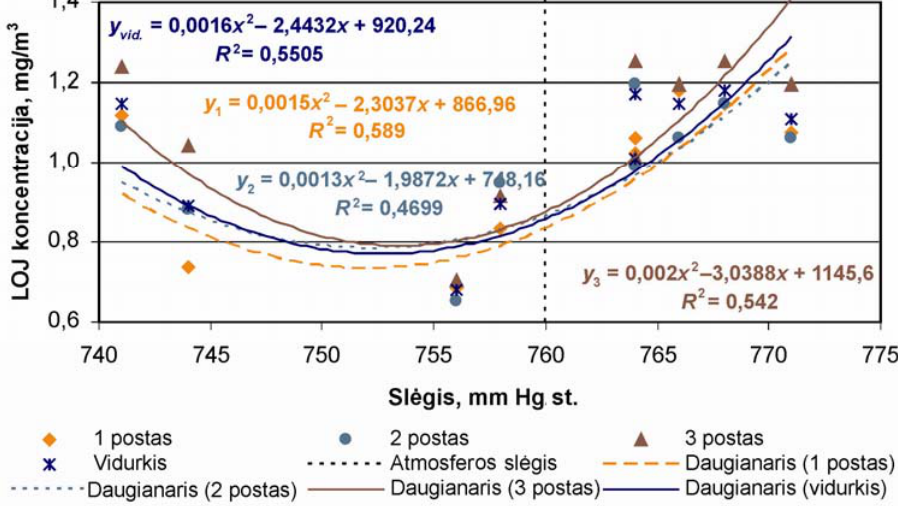
Fig 10. Dependence of VOC concentration in ambient air on relative humidity (7-day results)